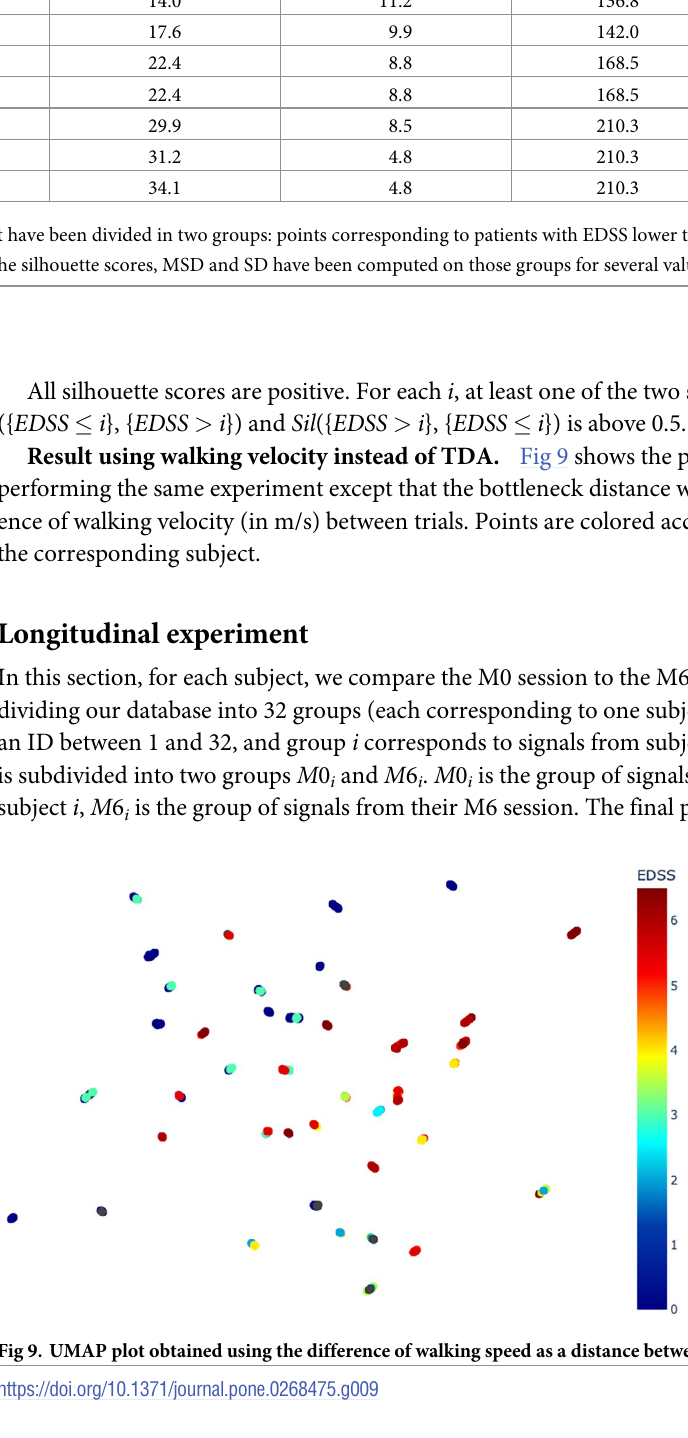
Table 3. Features for points with EDSS lower or equal to/ stricly higher than each threshold.